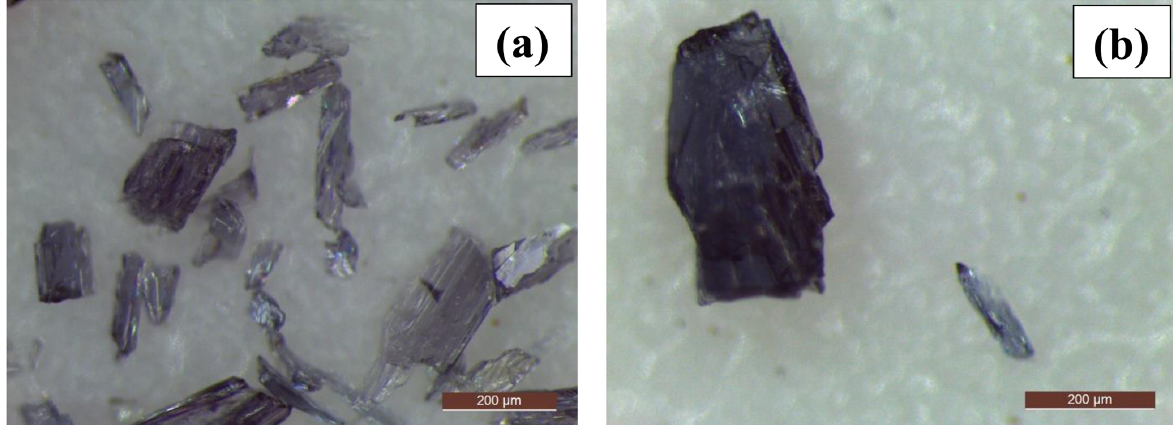
Figure B1. (a, b) Fragments detached from the hand sample by applying finger pressure and by scraping with tongs. The images were recorded at 10 × in